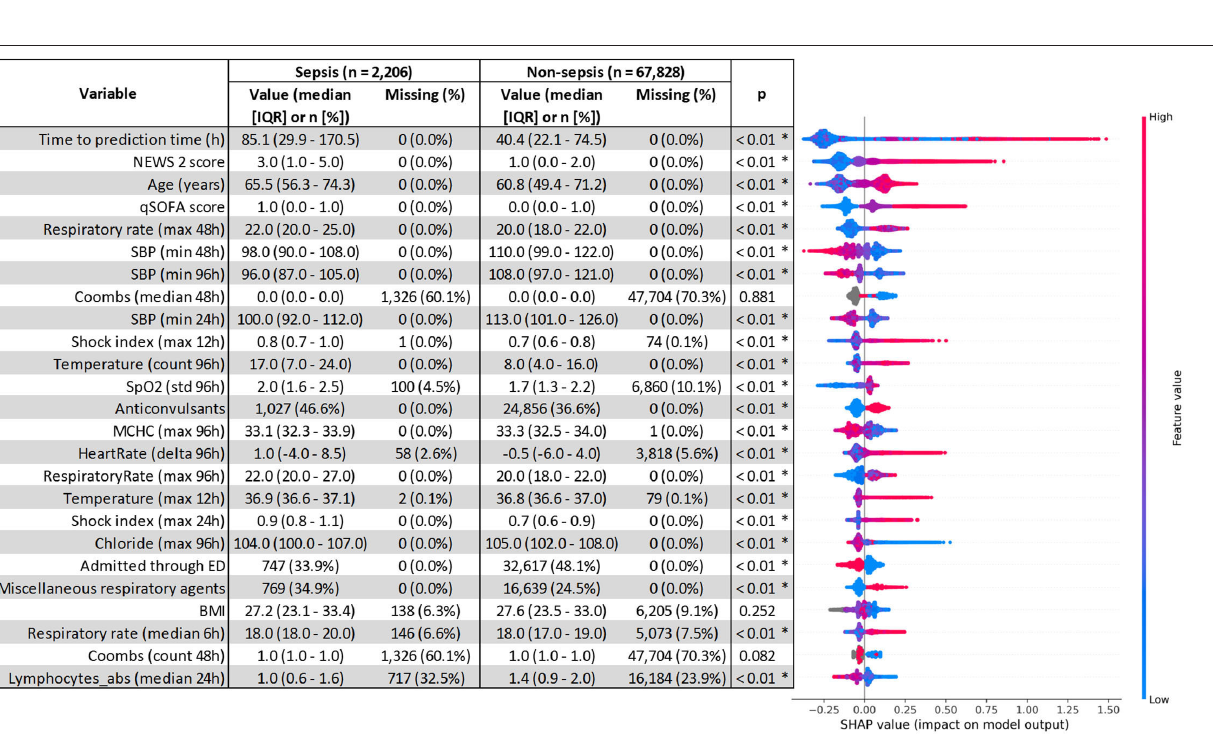
FIGURE 2 | SHapley Additive exPlanations (SHAP) feature importance. Comparison of variables between the sepsis and non-sepsis cohort was performed using the Mann–Whitney U test for continuous variables, and χ 2 for categorical variables. Statistical significance ( p < 0.01) is denoted by *. qSOFA, quick sequential organ failure assessment; NEWS2, national early warning system 2; SBP, systolic blood pressure; WBC, white blood cell count; MAP, mean arterial pressure.